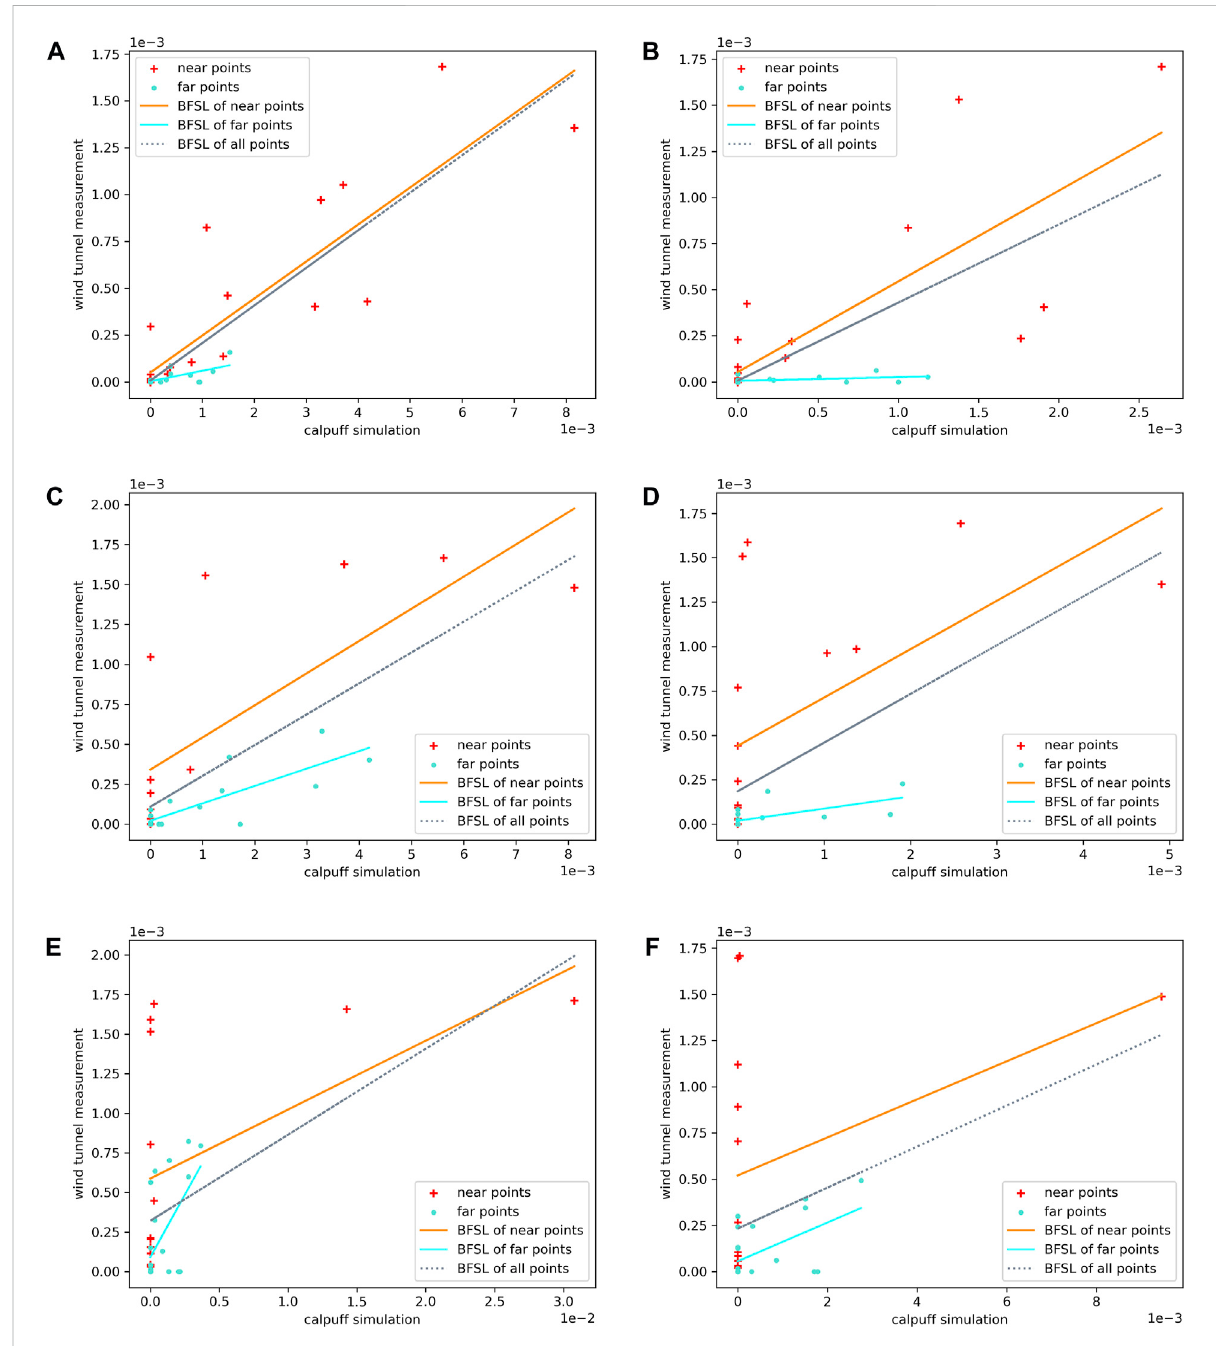
FIGURE 6 Scatter plots for the gas concentration dilution ratio of wind tunnel observation and CALPUFF simulation results: (A) N direction, 3 m/s, (B) N direction, 6 m/s, (C) S direction, 3 m/s, (D) S direction, 6 m/s, (E) E direction, 3 m/s, and (F) E direction, 6